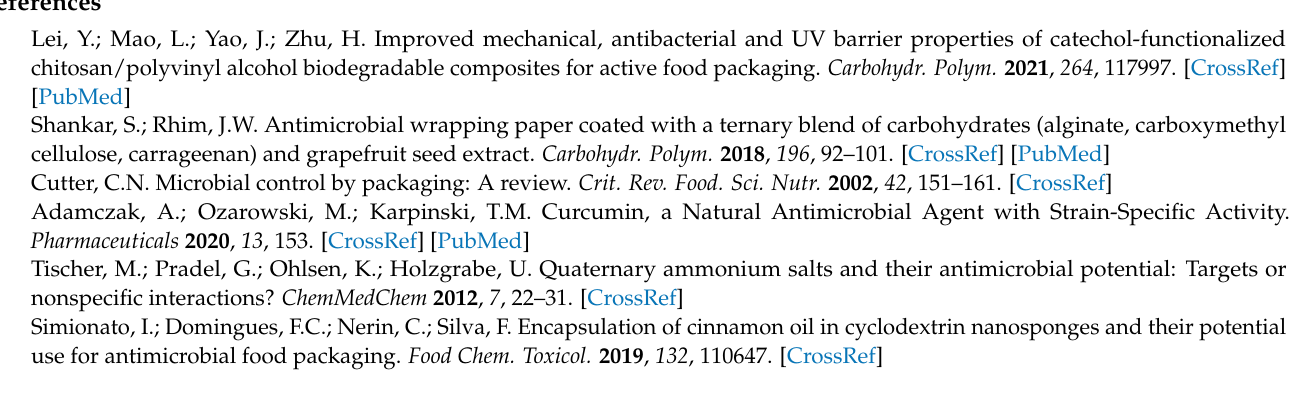
Figure S2. XPS spectra of DAC@Ag0-DAC@Ag5 composite films: (a) full scan spectrum, (b) C1s region, (c) O1s region and (d) Ag3d